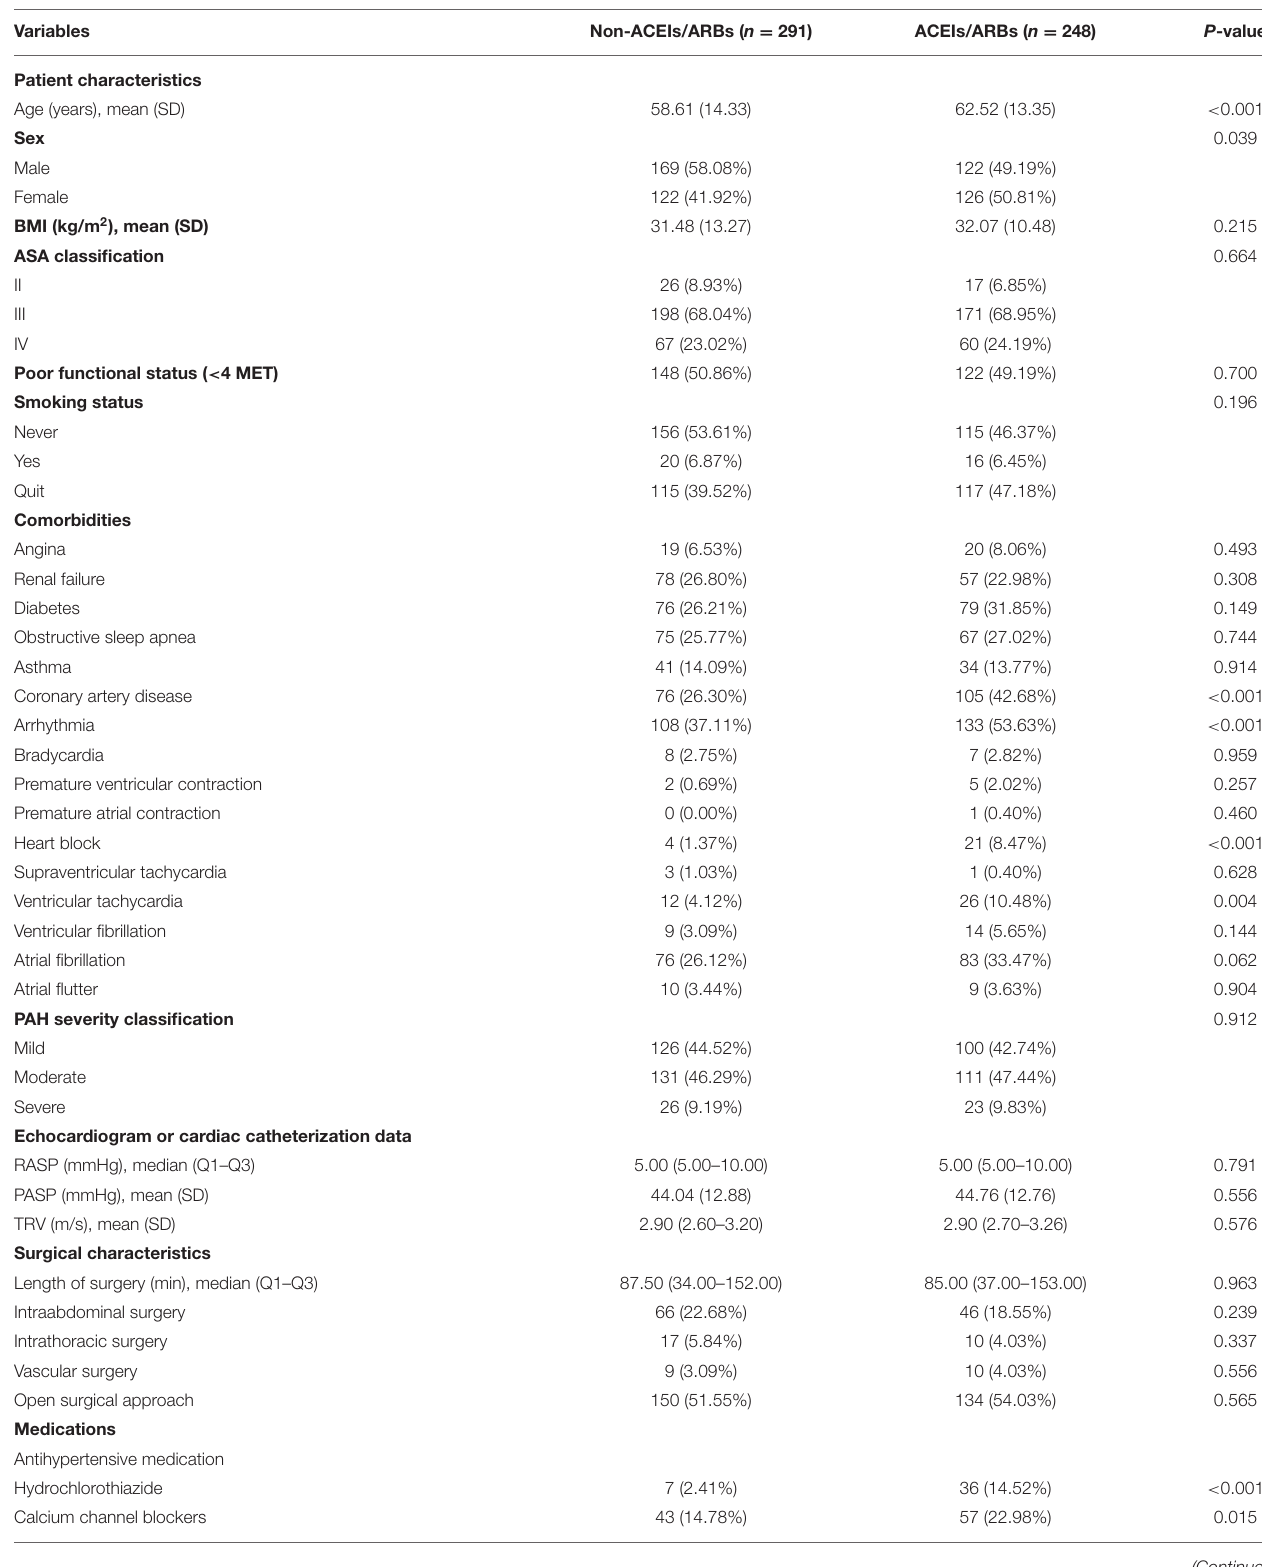
TABLE 1 | Baseline